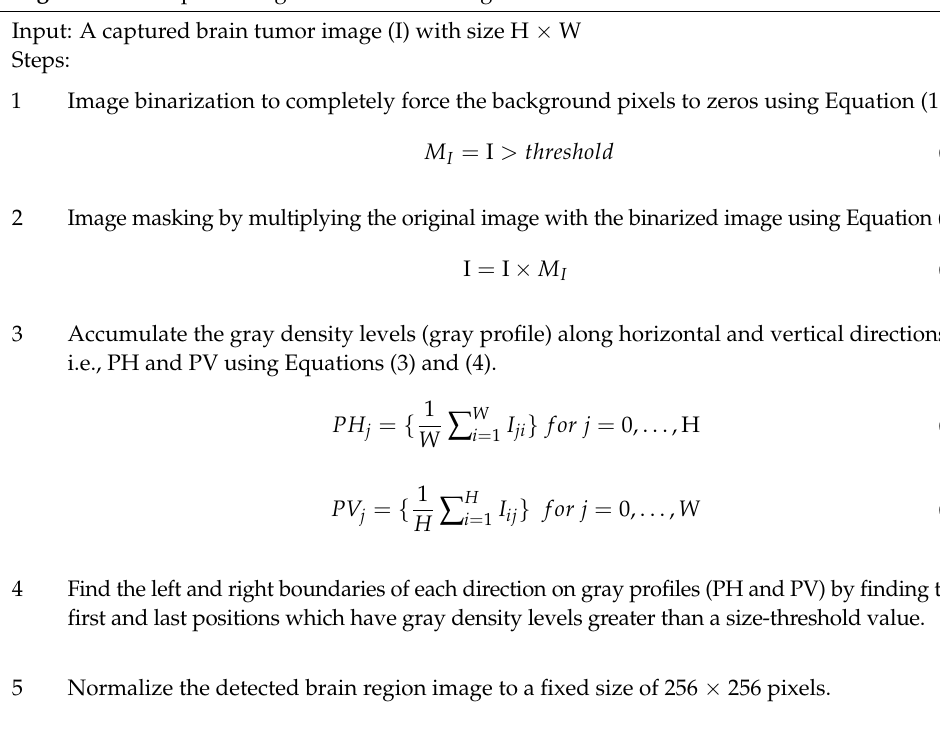
Algorithm 1 : Preprocessing of brain tumor